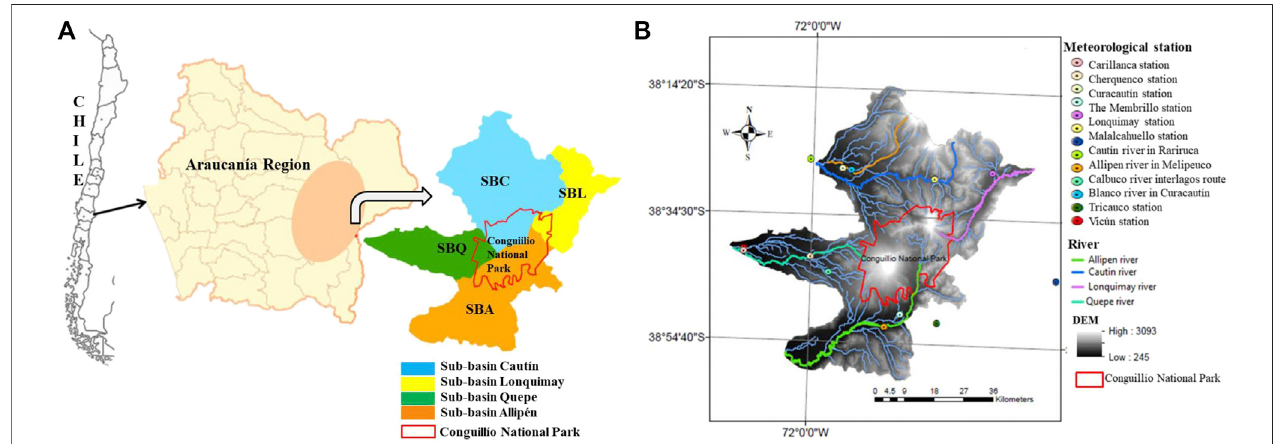
FIGURE 1 | (A) Map of Chile, Araucanía Region, sub-basins of the study area, and Conguillío National Park. (B) Geographical data of the study area, including location of meteorological stations and the rivers Cautín, Quepe, Lonquimay and Allipén.